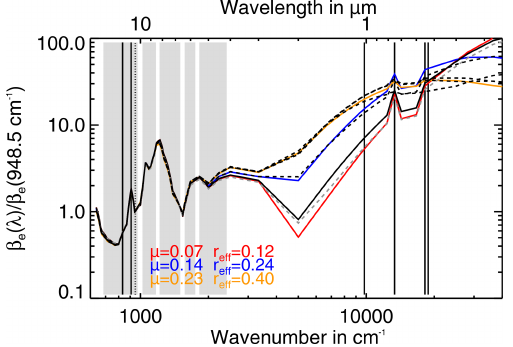
Figure 4. Extinction coefficient spectra normalised to 1 at 948.5cm − 1 for modelled sulfate aerosol particle size distributions (coloured lines) and measured size distributions after Pinatubo (black dashed lines; Deshler et al., 1992a, b, 1993, Arctic), Nabro (grey dashed line; Bourassa et al., 2012b, July, Wyoming), and background aerosol at 20km (black solid line; Deshler et al., 2003, April 1999). The corresponding scaling factors are given in Table 3.